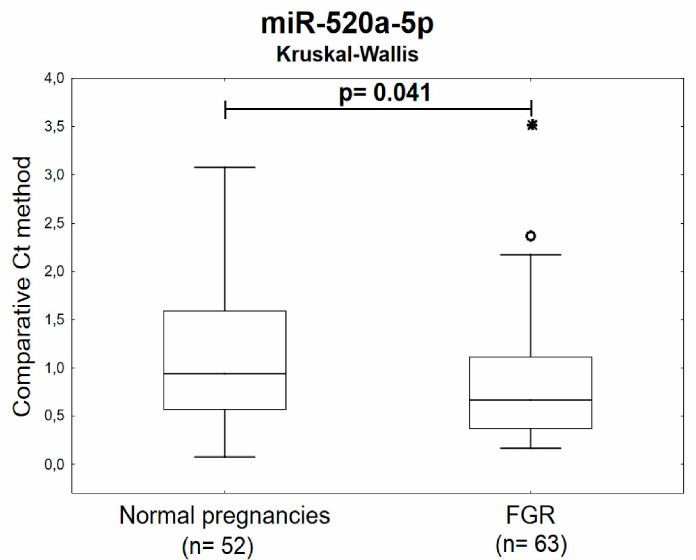
Figure 6. Down-regulation of miR-520a-5p in plasma exosomes during the first trimester of gestation in women with subsequent onset of FGR. Decreased levels of miR-520a-5p were observed in circulating plasma exosomes within 10 to 13 weeks of gestation in women affected with FGR when the comparison to the controls was performed using the Kruskal-Wallis test. FGR: fetal growth restriction. Outliers are marked by circles ( ⸰ ), and extremes by asterisks (*)